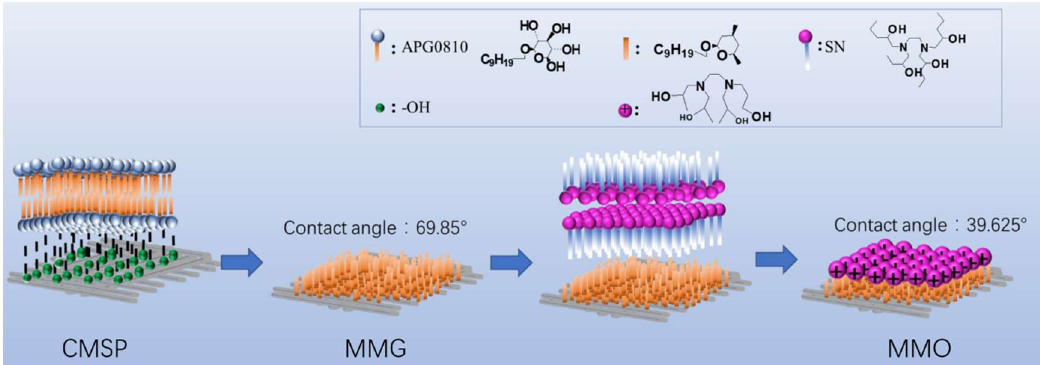
Figure 11. Schematic diagram of surfactant molecules APG and SN interacting with the surface CMSP during the two-step hydrotherm-assisted adsorption.